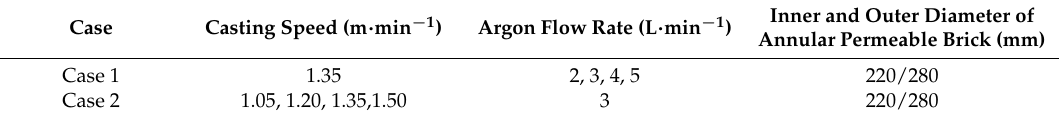
Table 2. Mathematical simulation scheme.